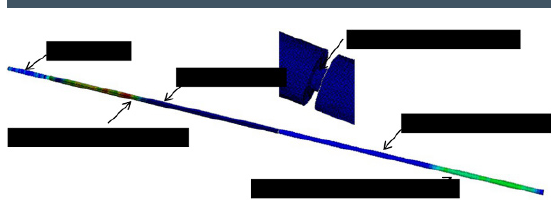
Figure 6. 3-D finite element model of SHPB